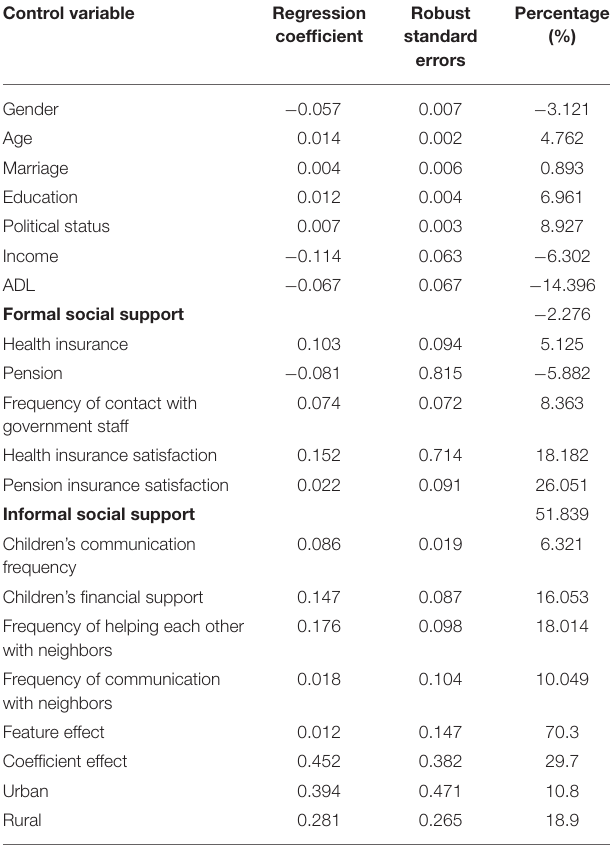
TABLE 7 | Oaxaca blinder